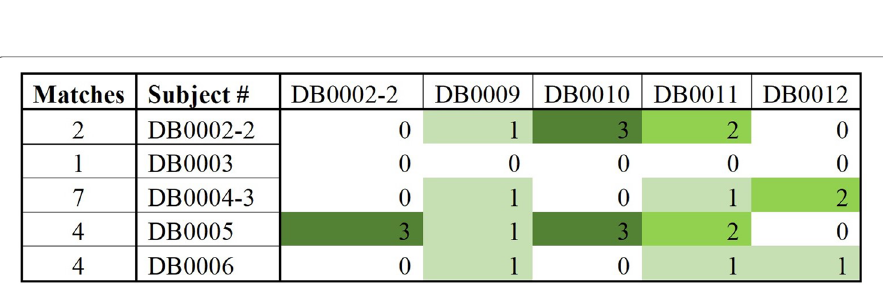
Fig. 2 Sample of the cumulative matrix showing layout and color